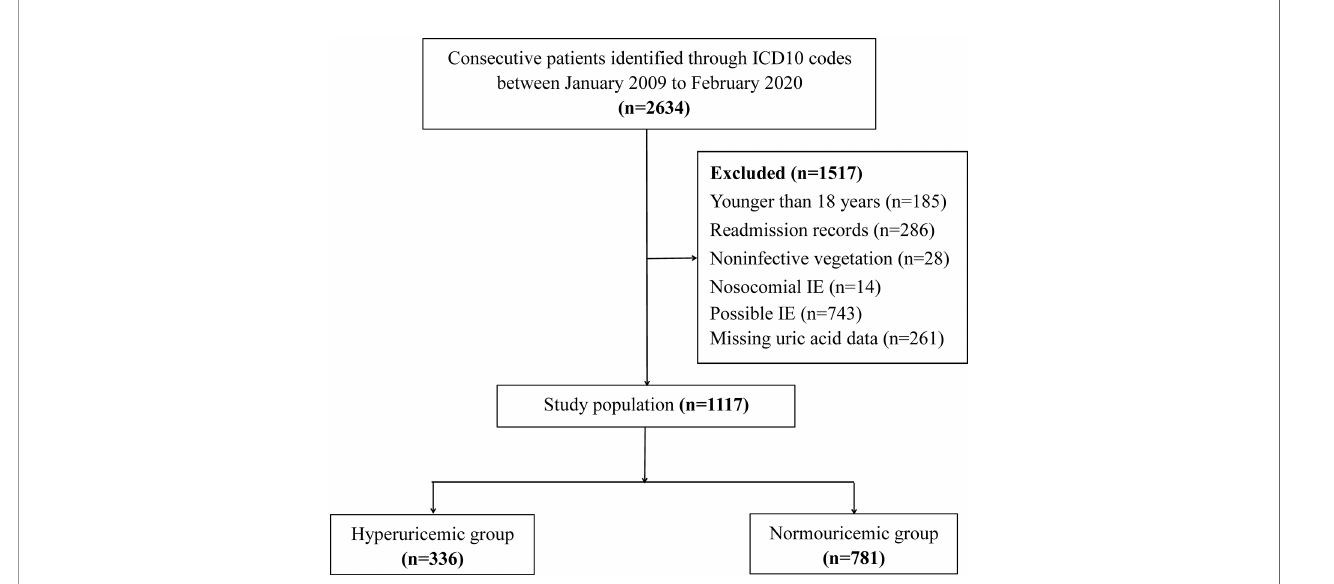
FIGURE 1 | Flow chart of patient